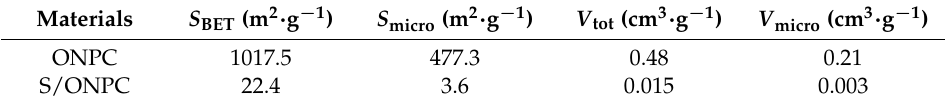
Figure 1. Nitrogen adsorption/desorption isotherms ( a ) and size distribution ( b ) of the ONPC and S/ONPC composite. Table 1. BET results (surface area and pore volume) for the ONPC and S/ONPC.